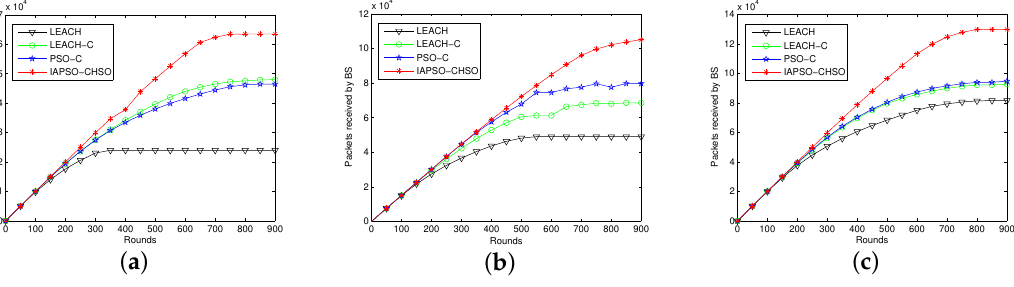
Figure 7. Comparison in terms of data packets received by BS with 100 to 200 nodes. ( a ) 100 nodes with 6 cluster heads; ( b ) 150 nodes with 9 cluster heads; ( c ) 200 nodes with 12 cluster